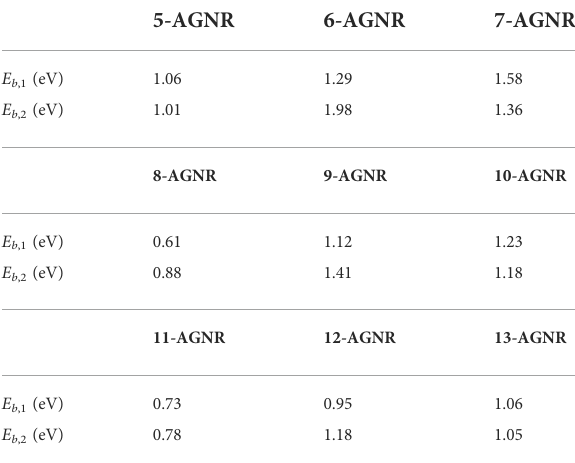
TABLE 1 Exciton binding